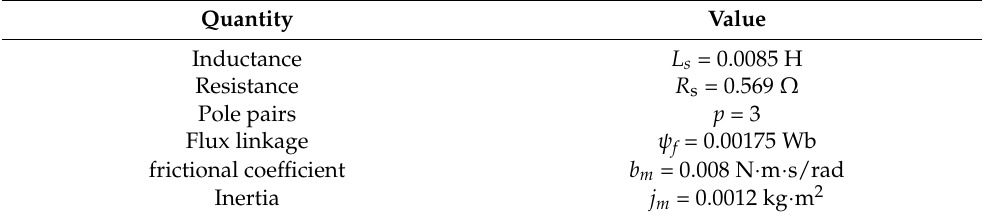
Table 1. Parameters of the PMSM.